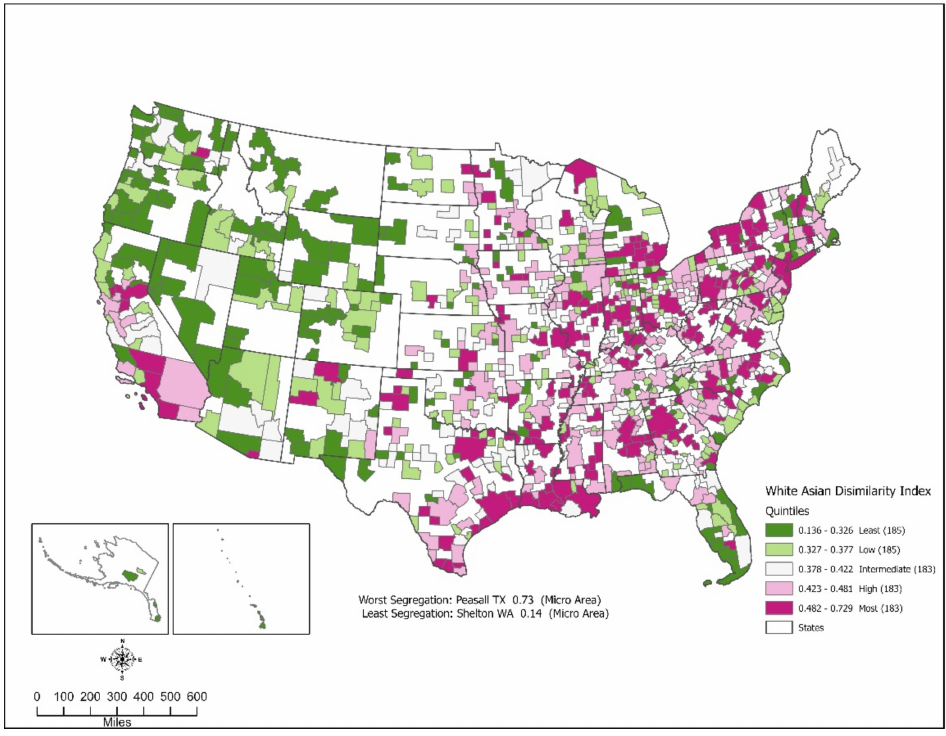
Figure 16. Asian-White Dissimilarity Indices, Metro/Micro Areas,